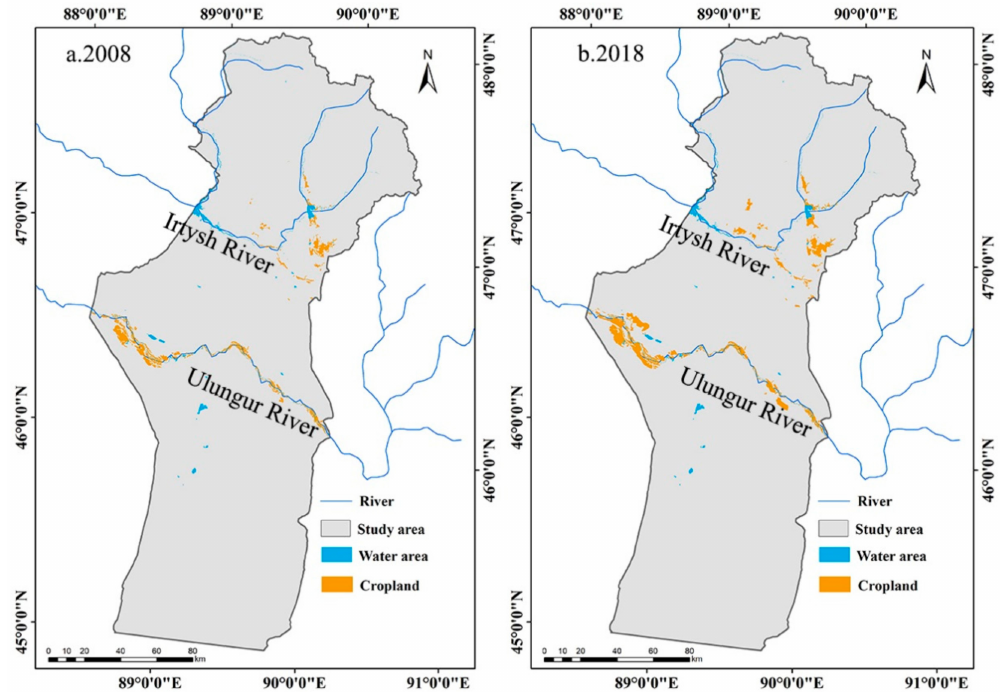
Figure 13. Spatial distribution map of cropland in 2008 and